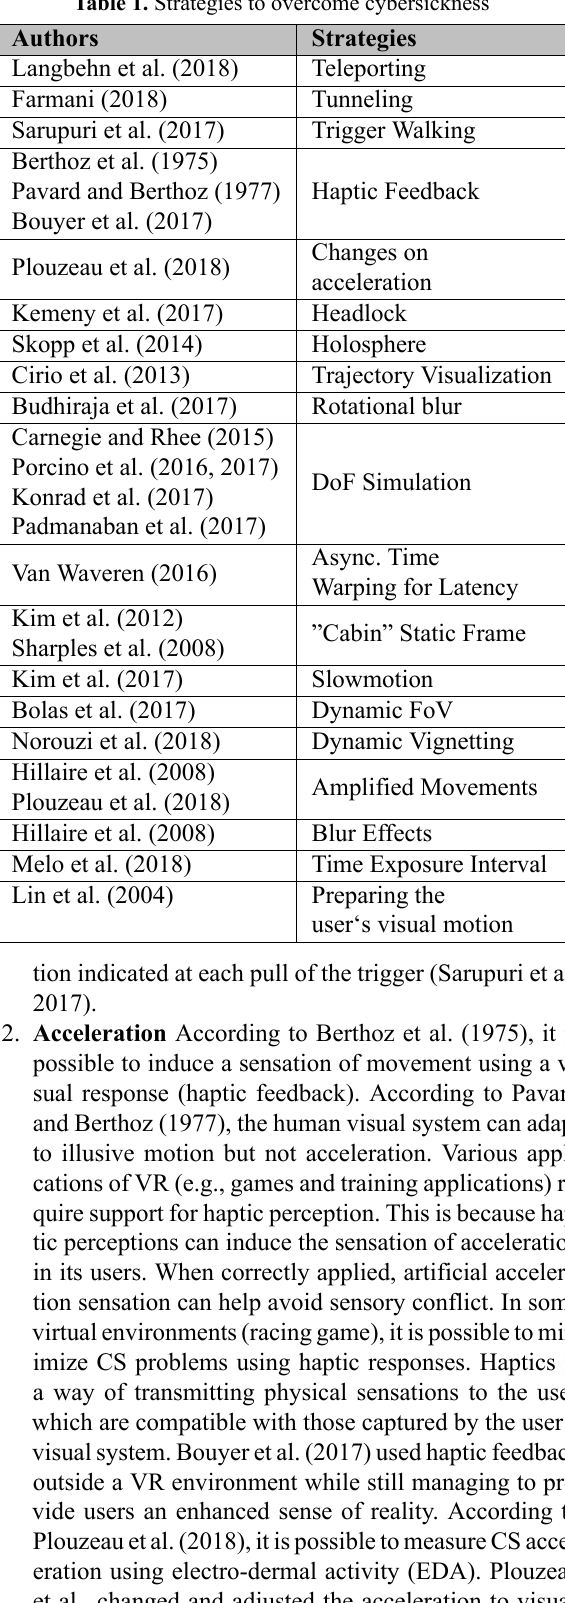
Table 1. Strategies to overcome